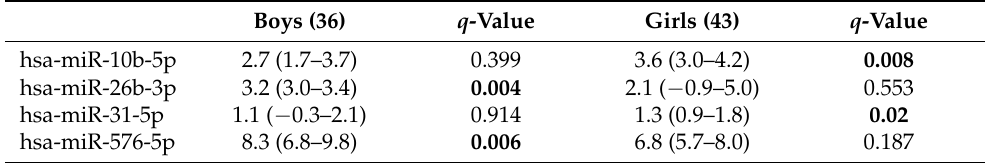
Table 2. Association of miRNA expression levels with CRP.